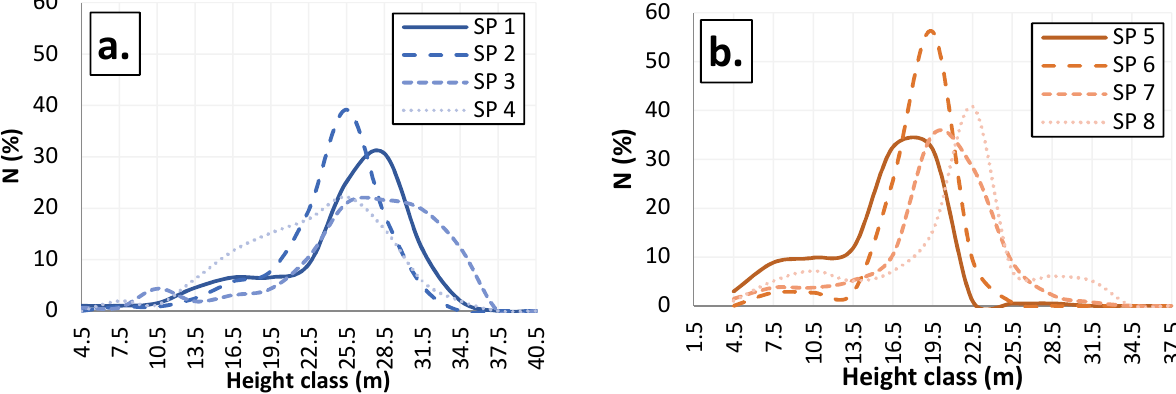
Figure 3. Distribution of trees by height classes in the Serbian spruce ( a ) and Macedonian pine ( b ) stands.